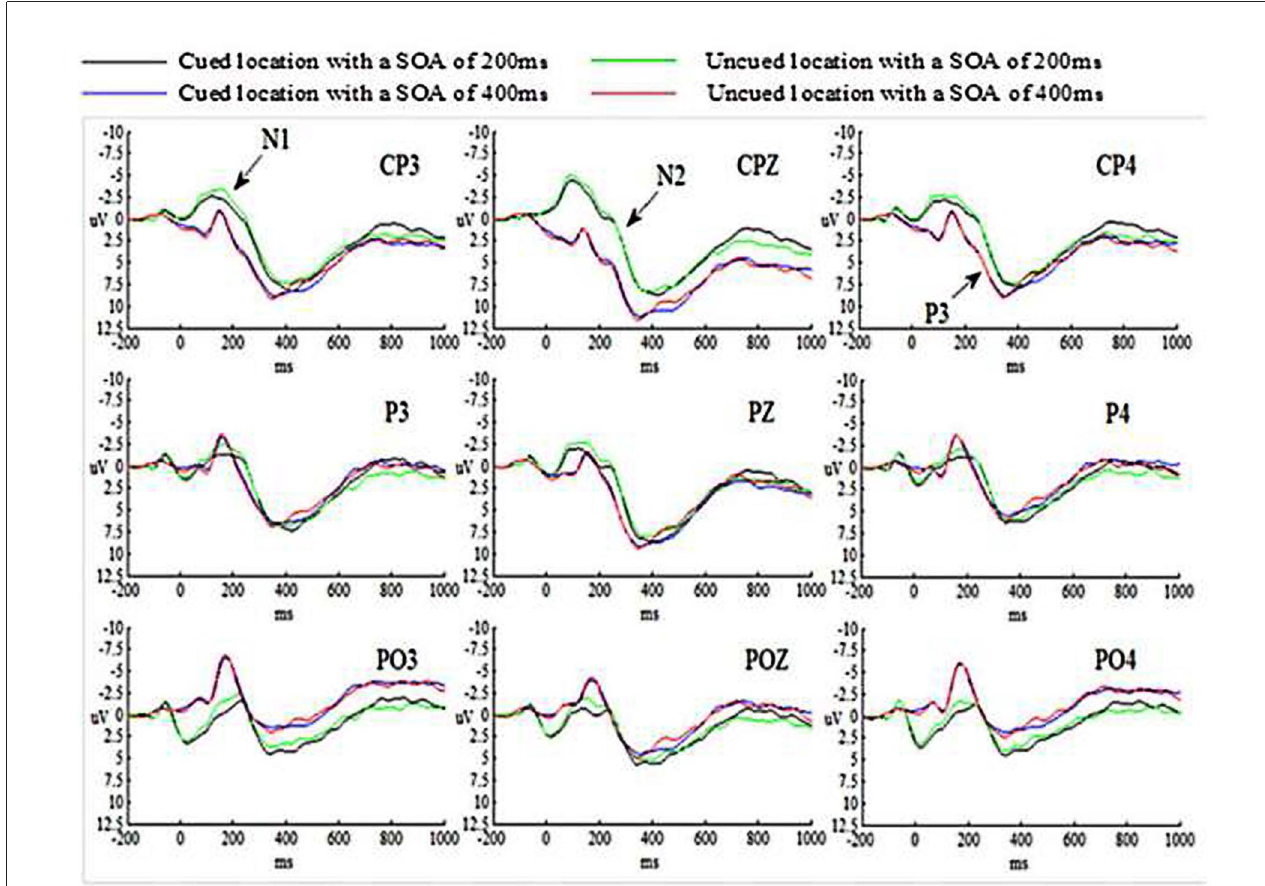
FIGURE 2 | Grand-averaged event-related potential (ERP) waveforms for the novices in Experiment 1.